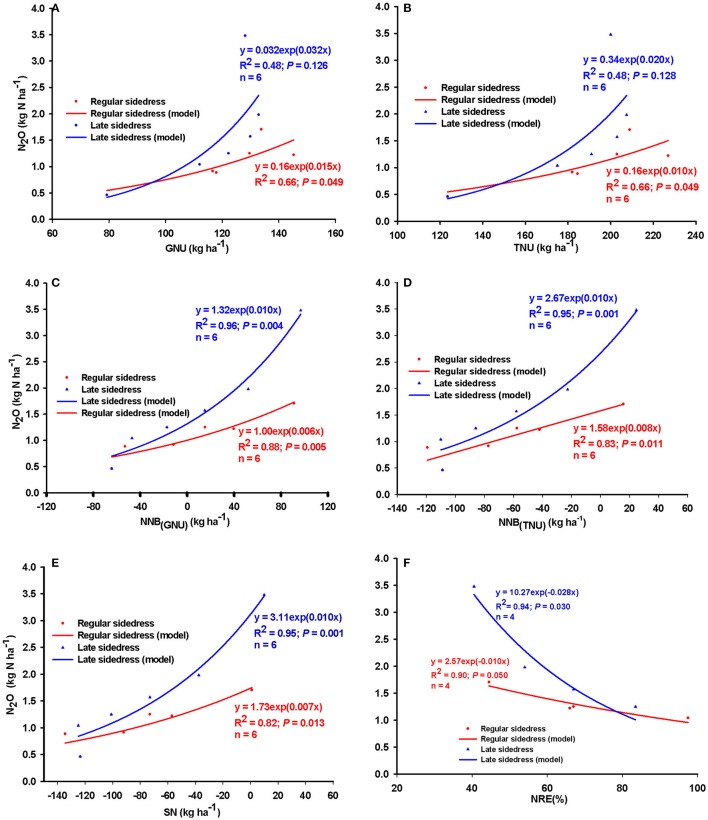
Relationships between nitrous oxide (N2O) emission and (A) grain N (GNU) and (B) total N uptake (TNU), net N balance for (C) grain N [NNB(GNU)], (D) total N uptake [NNB(TNU)] and (E) surplus N (SN), and (F) N recovery efficiency (NRE) when N was applied at early/regular sidedress (V6) and late sidedress (V14) in Minnesota. n = number of N rate groups, and points within each n group are mean values of 2 observations.